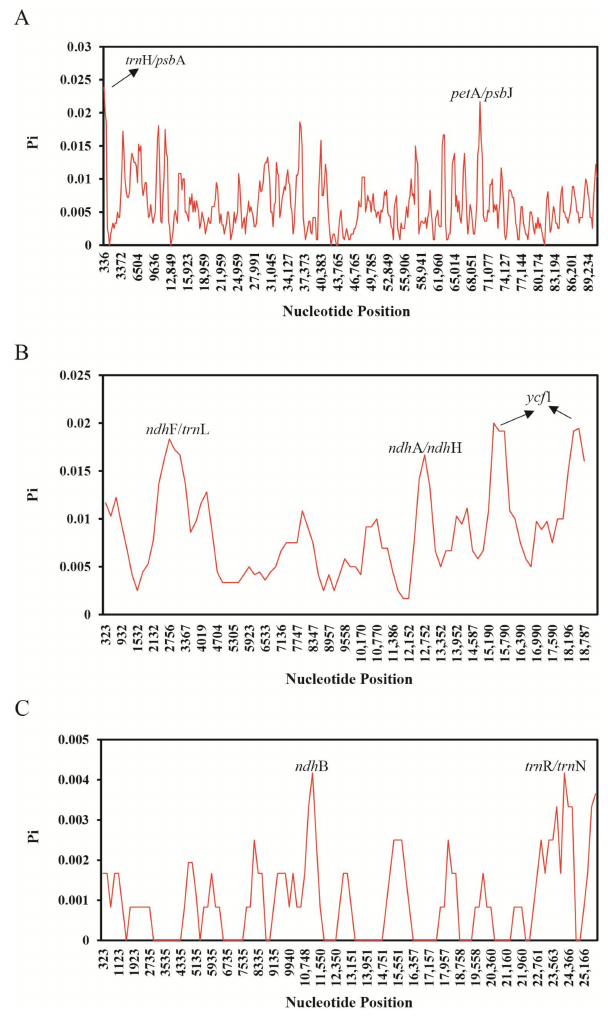
Figure 7. Comparative analysis of nucleotide variability ( Pi ) values among the four Quercus cp genome sequences. ( A ) Analysis of the LSC regions; ( B ) Analysis of the SSC regions; ( C ) Analysis of the IR regions. (Window length: 600 bp, step size: 200 bp). X -axis: position of the midpoint of a window, Y -axis: nucleotide diversity of each